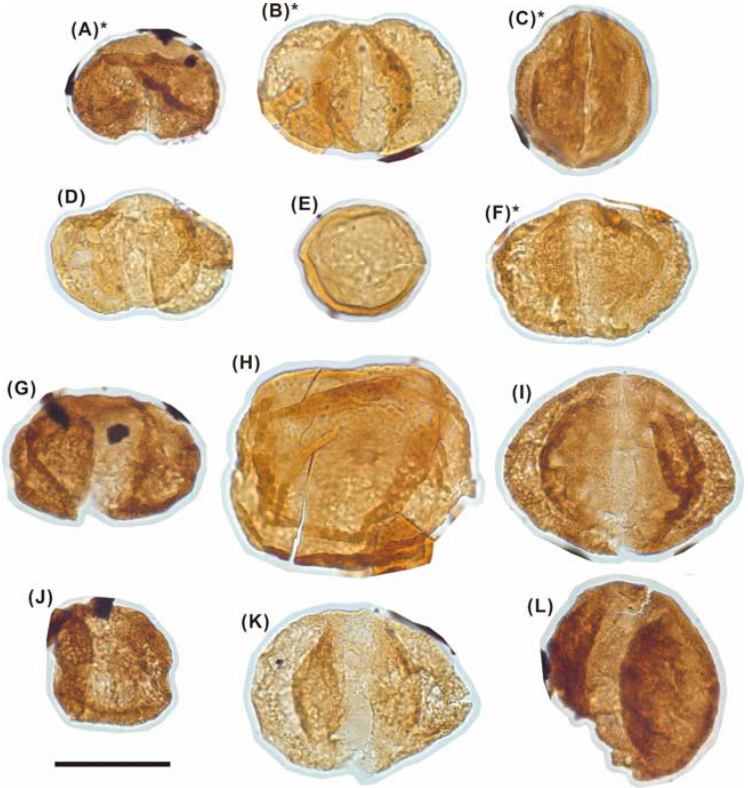
Figure 6. Photomicrographs of selected pollen in oil shale and coal. ( A ) Pinuspollenites sp. ( B ) Podocarpidites sp. ( C ) Protoconiferus sp. ( D ) Alisporites sp. ( E ) Araucariacutes sp. ( F ) Piceites sp. ( G ) Piceaepollenites sp. ( H ) Psophosphaera sp. ( I ) Protopinus sp. ( J ) Quadraeculina sp. ( K ) Pseudopicea sp. ( L ) Pristinuspollenites sp. The scale bar represents 50 μ m. The photomicrographs marked with * are from [29].